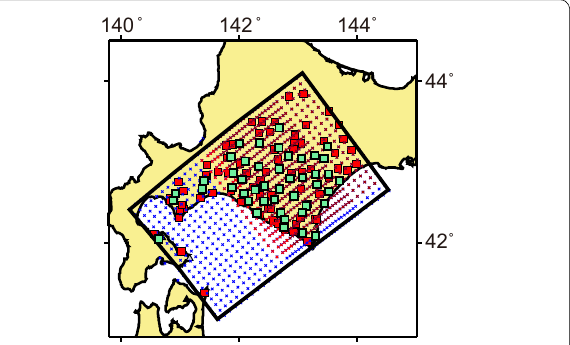
Fig. 2 Distribution of stations and grid configurations (red and blue crosses) used in the relocation by the double-difference tomography method. The relocation of the present study shown in Fig. 3 used permanent seismic stations, which are denoted as red squares. Green squares denote the temporary stations which were operated in 1999 to 2001 (Katsumata et al. 2003). Both the permanent and temporary stations were used in the estimation of the detailed seismic structure shown in Figs. 4 and